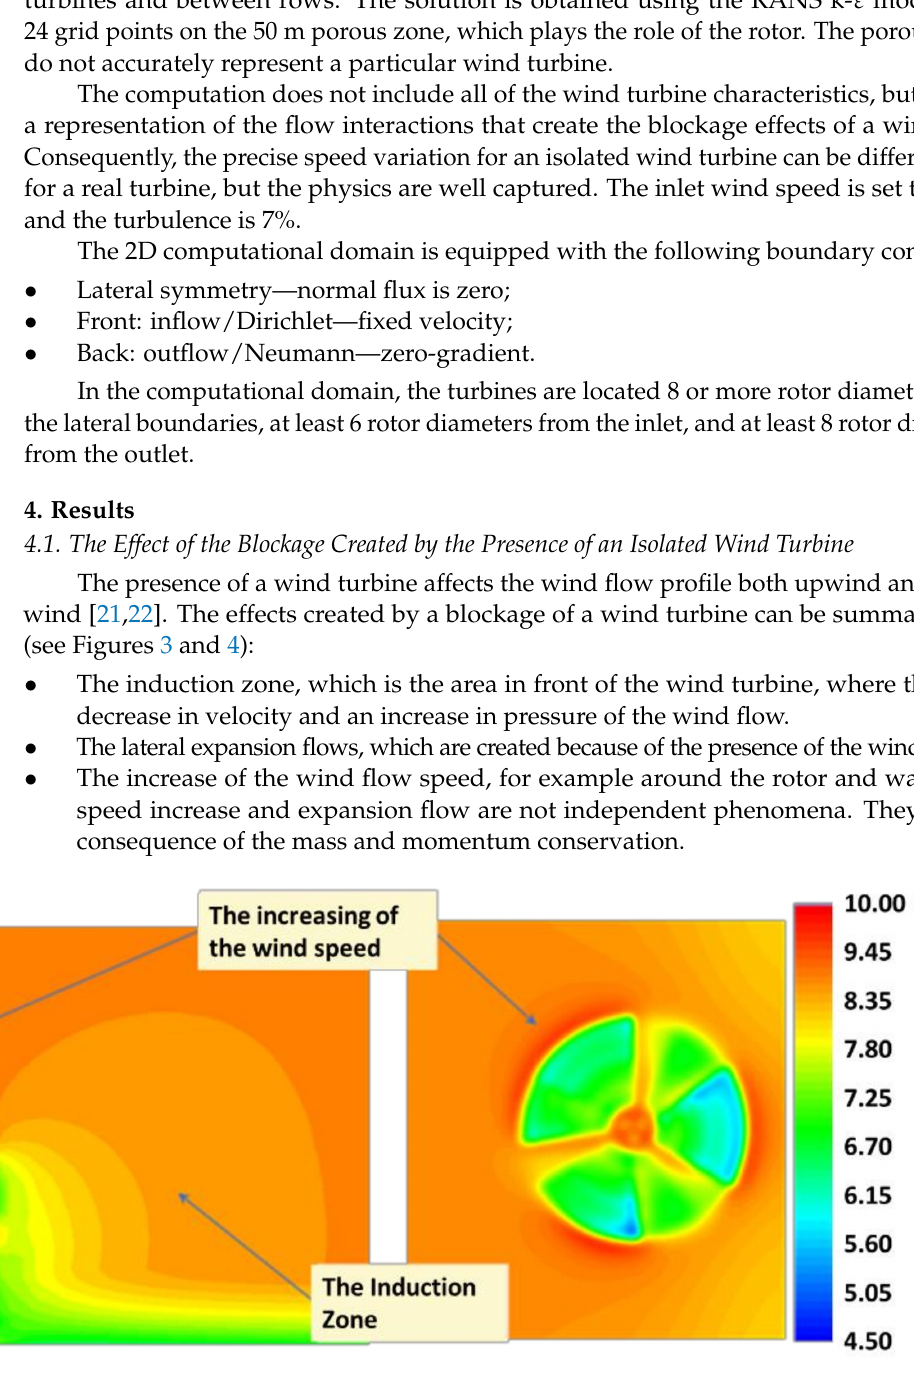
Figure 3. Velocity contour of the flow around one turbine; inlet speed = 9 m/s. Left: transversal section on the wind turbine, showing the induction zone in the front of the turbine and increasing wind flow around the wake. Right: velocity contours on the wind turbine rotor plane—wind speed increases around the